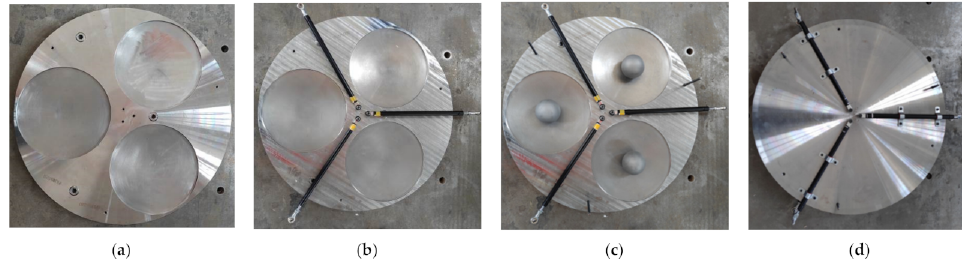
Figure 14. ( a ) Anchoring the lower support plate, ( b ) installing the lower dampers, ( c ) fixing the rolling ball and the locating rod, ( d ) installing the upper plate and